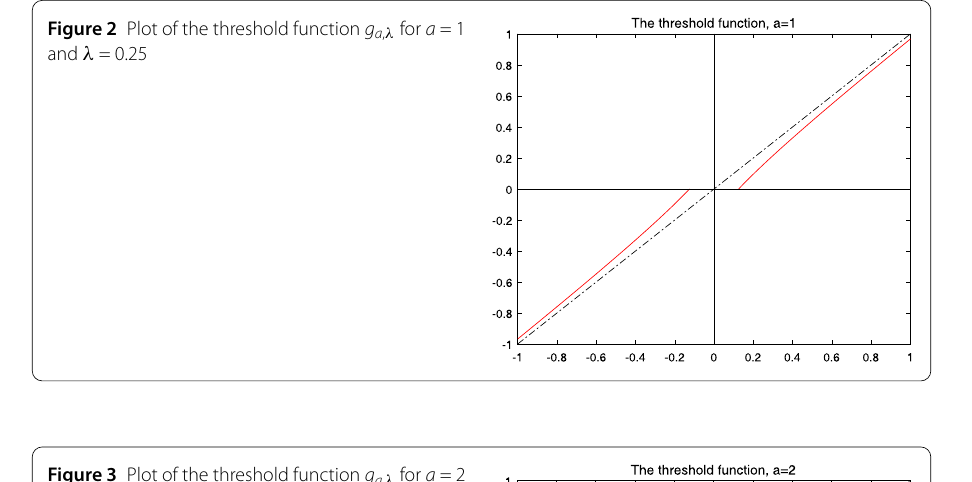
Figure 2 Plot of the threshold function g a , λ for a = 1 and λ = 0.25